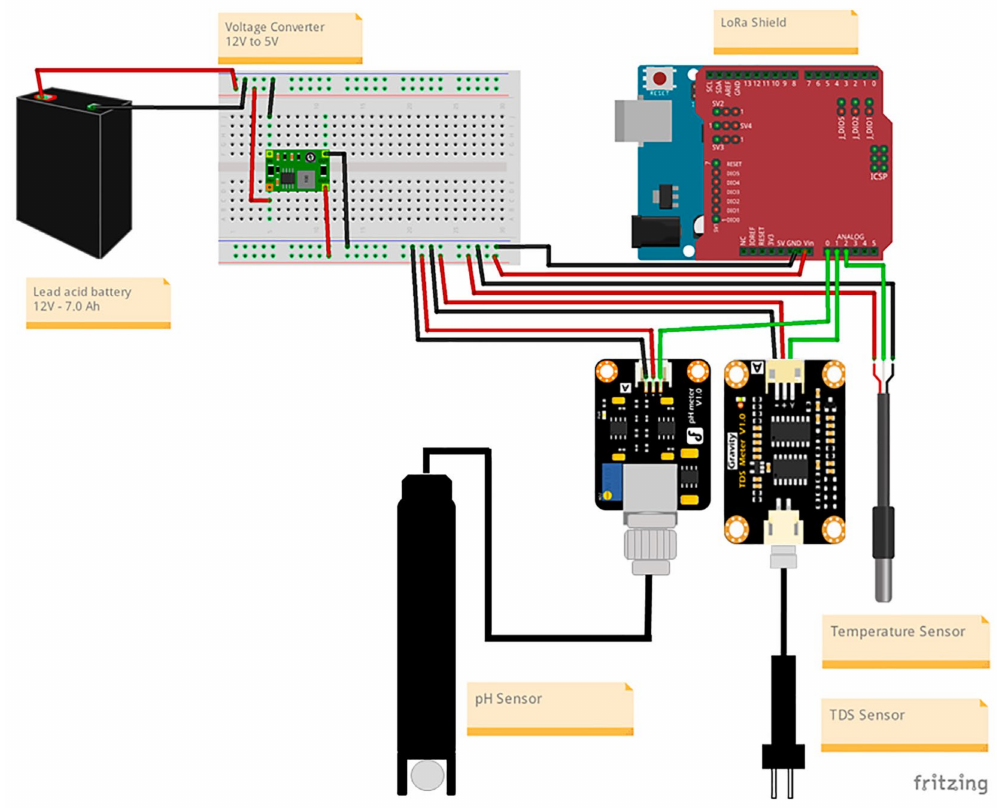
Figure 2. LoRA node connection